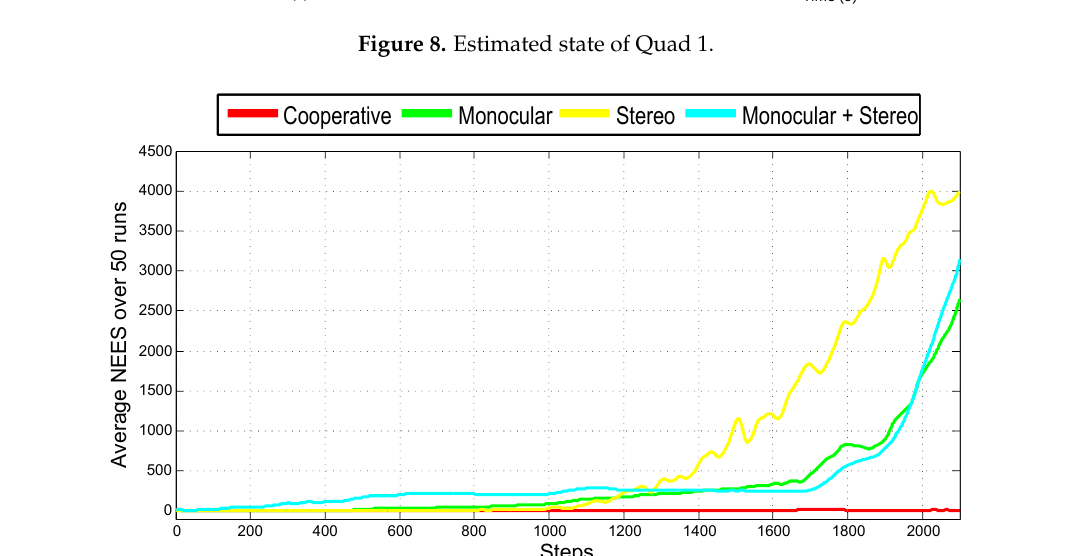
Figure 9. Average Normalized Estimation Error Squared (NEES) obtained with the four